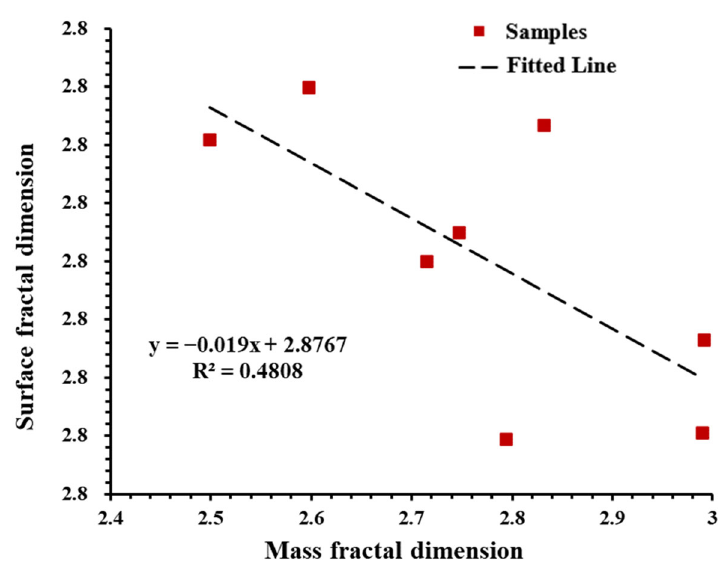
Figure 14. Relationship between the fractal dimension of the deep shale mass and surface fractal dimension.